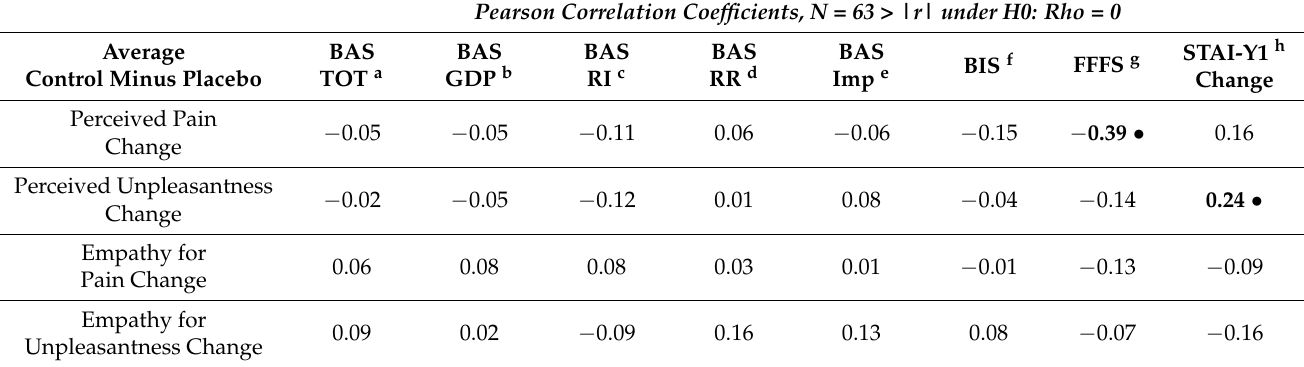
Table 1. Pearson correlations and descriptive statistics for behavioral and personality measures in 63 participants.